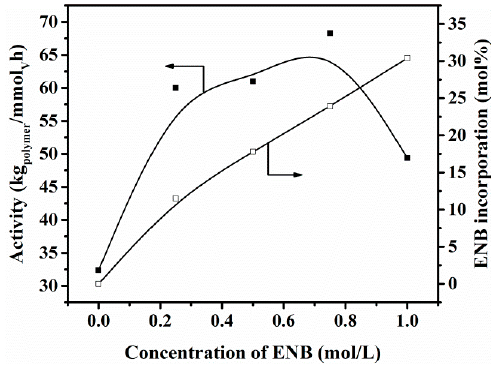
Figure 3. The influences of ENB concentration in feed on the catalytic activities of catalyst b and ENB incorporations in the E/ENB copolymers.